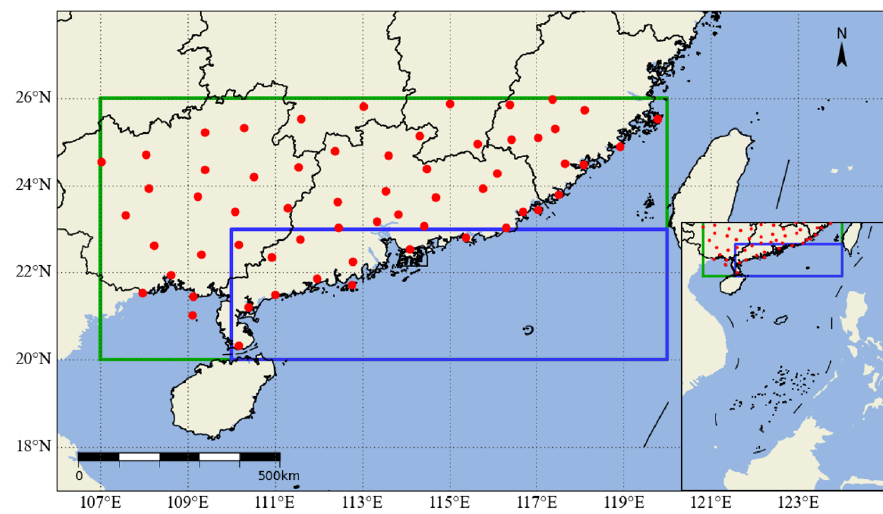
Figure 1. Schematic diagram of the South China (the red box represents the area where the precipi- tation is studied, the blue box is the judgment area of South China Sea summer monsoon onset, and the black spot is the meteorology stations).